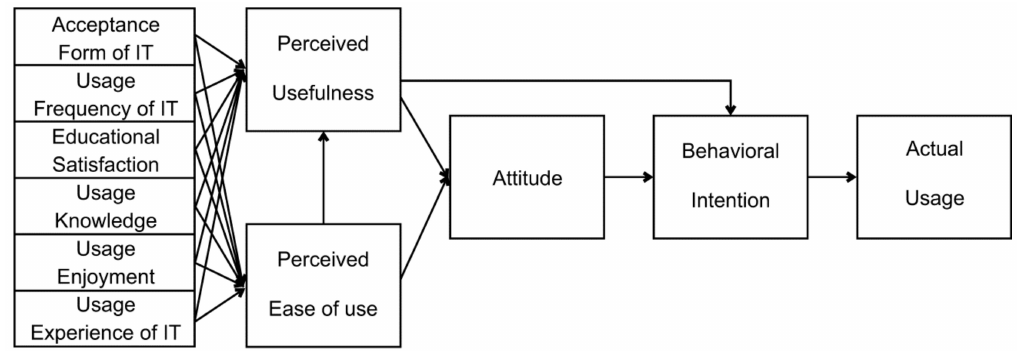
Figure 2. Technology acceptance model of construction information technology